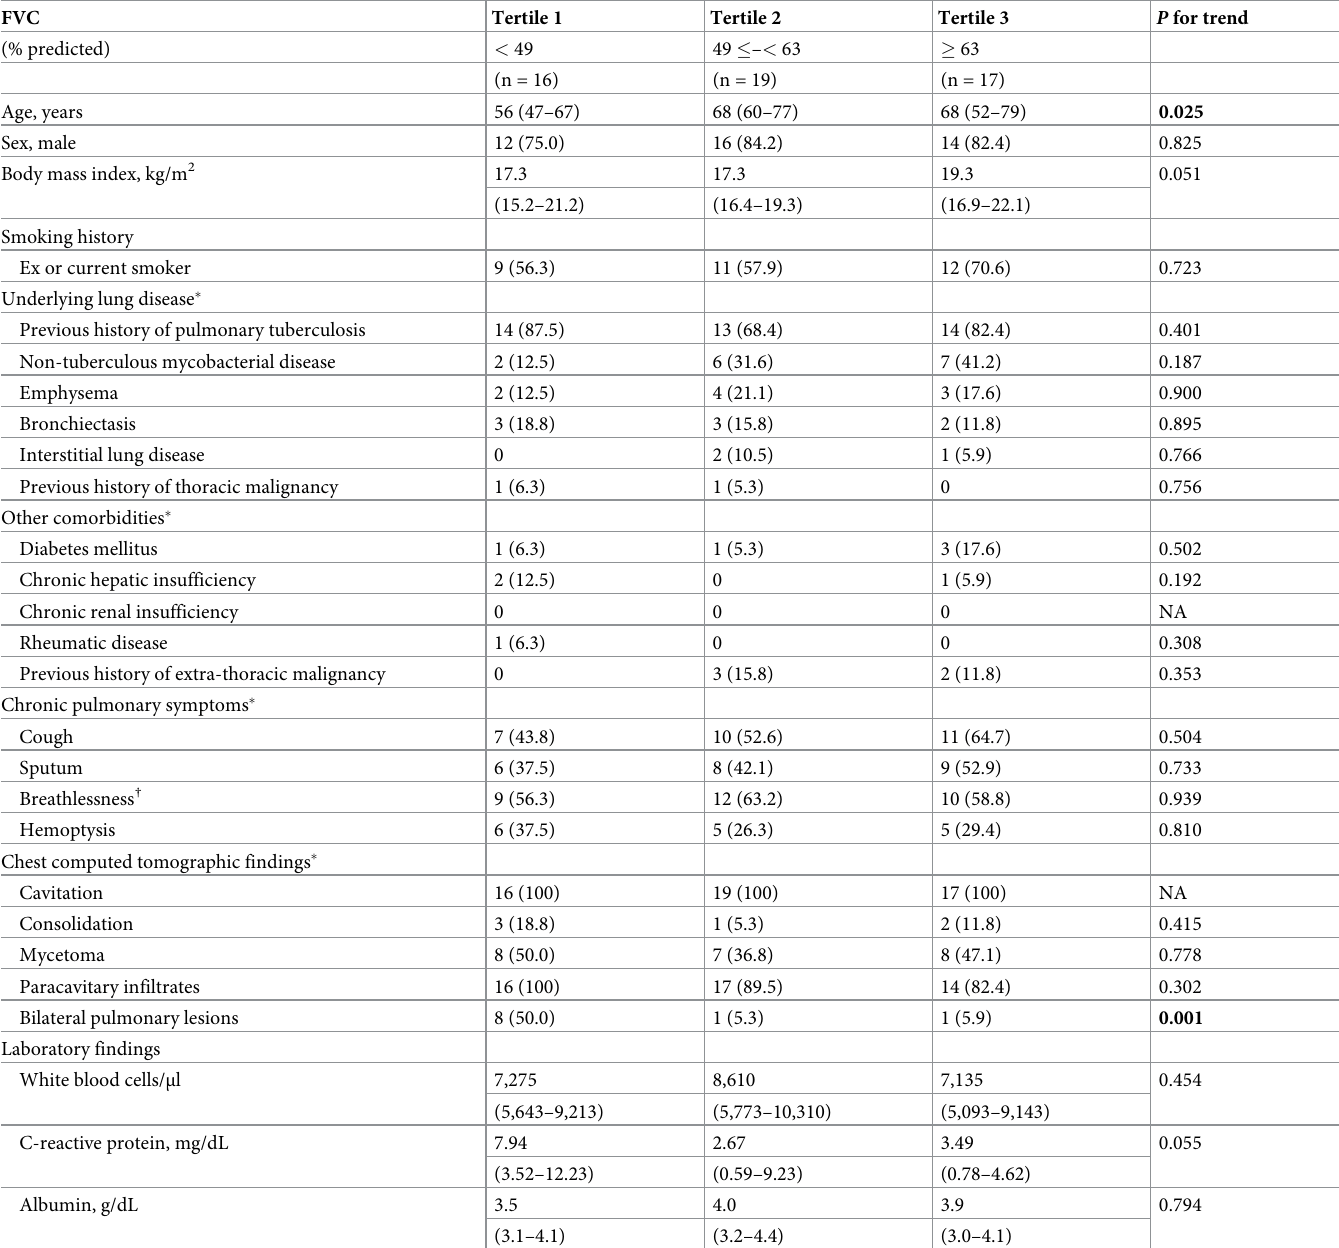
Table 3. RSP § patients’ characteristics by tertile of FVC (%